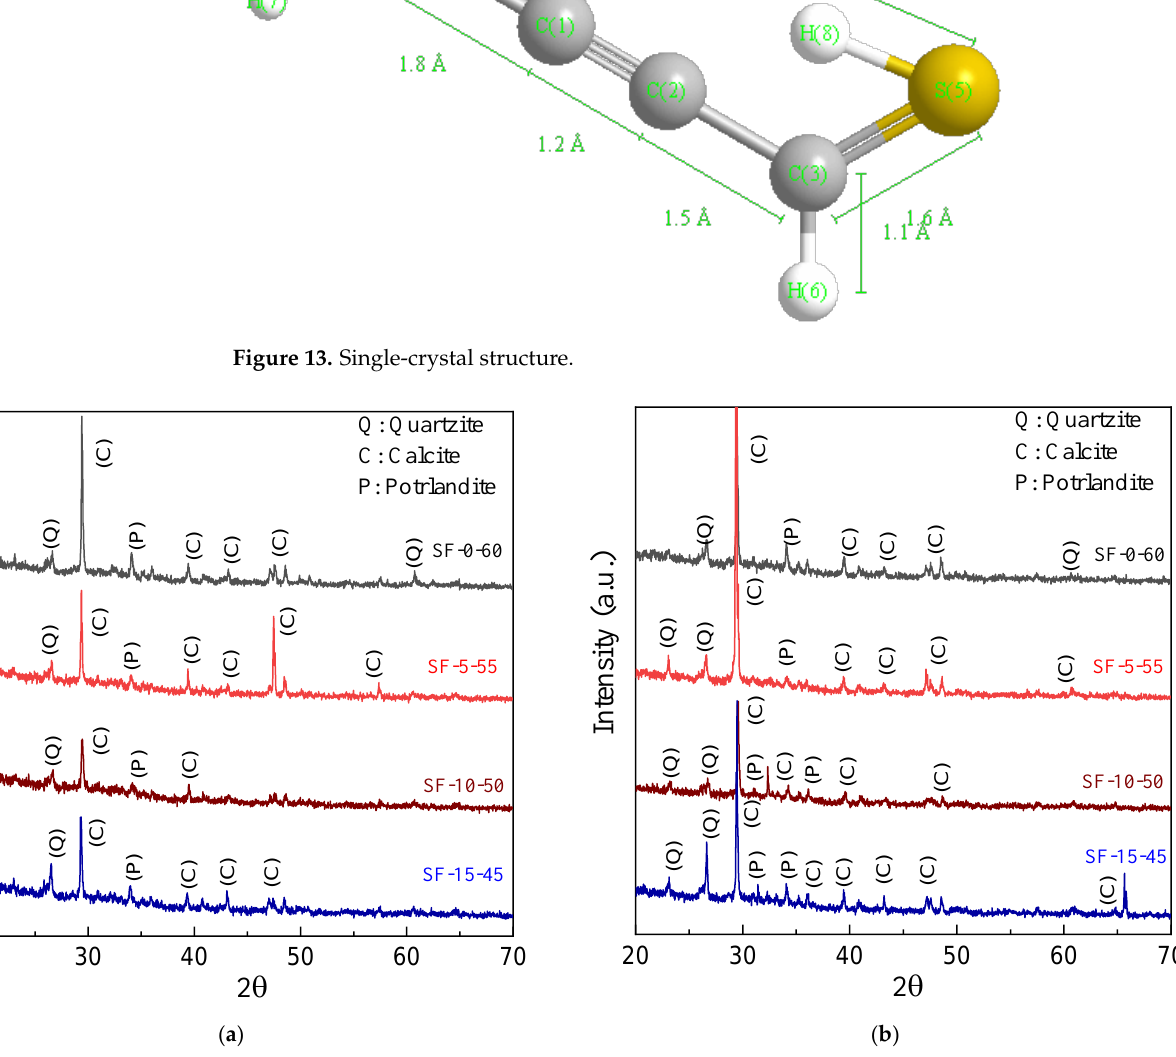
Figure 13. Single-crystal structure.